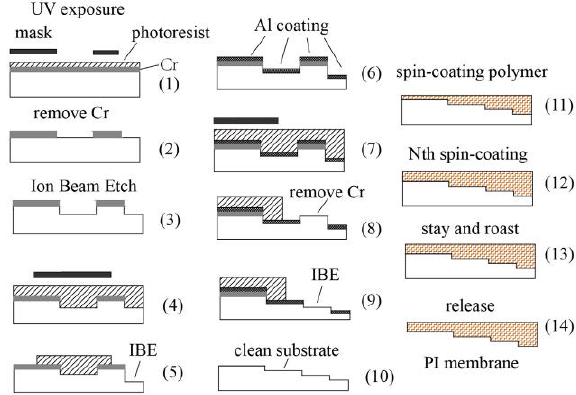
Figure 3. Fabrication process of 4-level membrane FZLs using self-aligned method